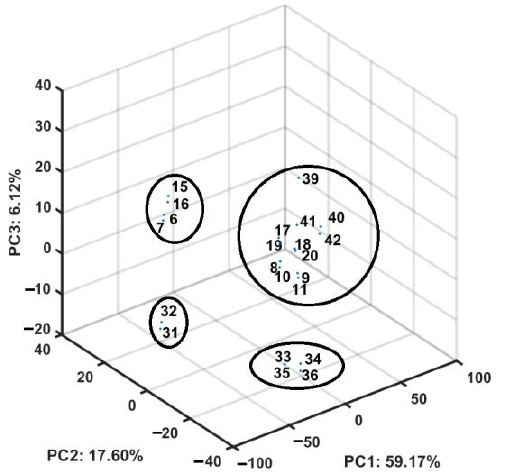
Figure 9. A 3D scoreplot of carborane-based conjugates.